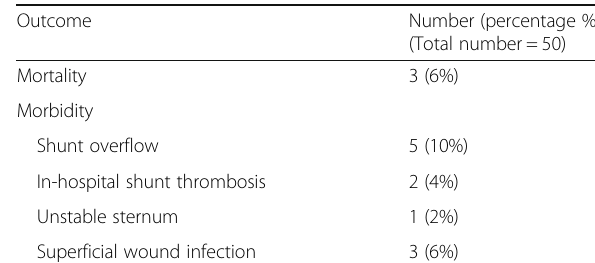
Table 2 Mortality and